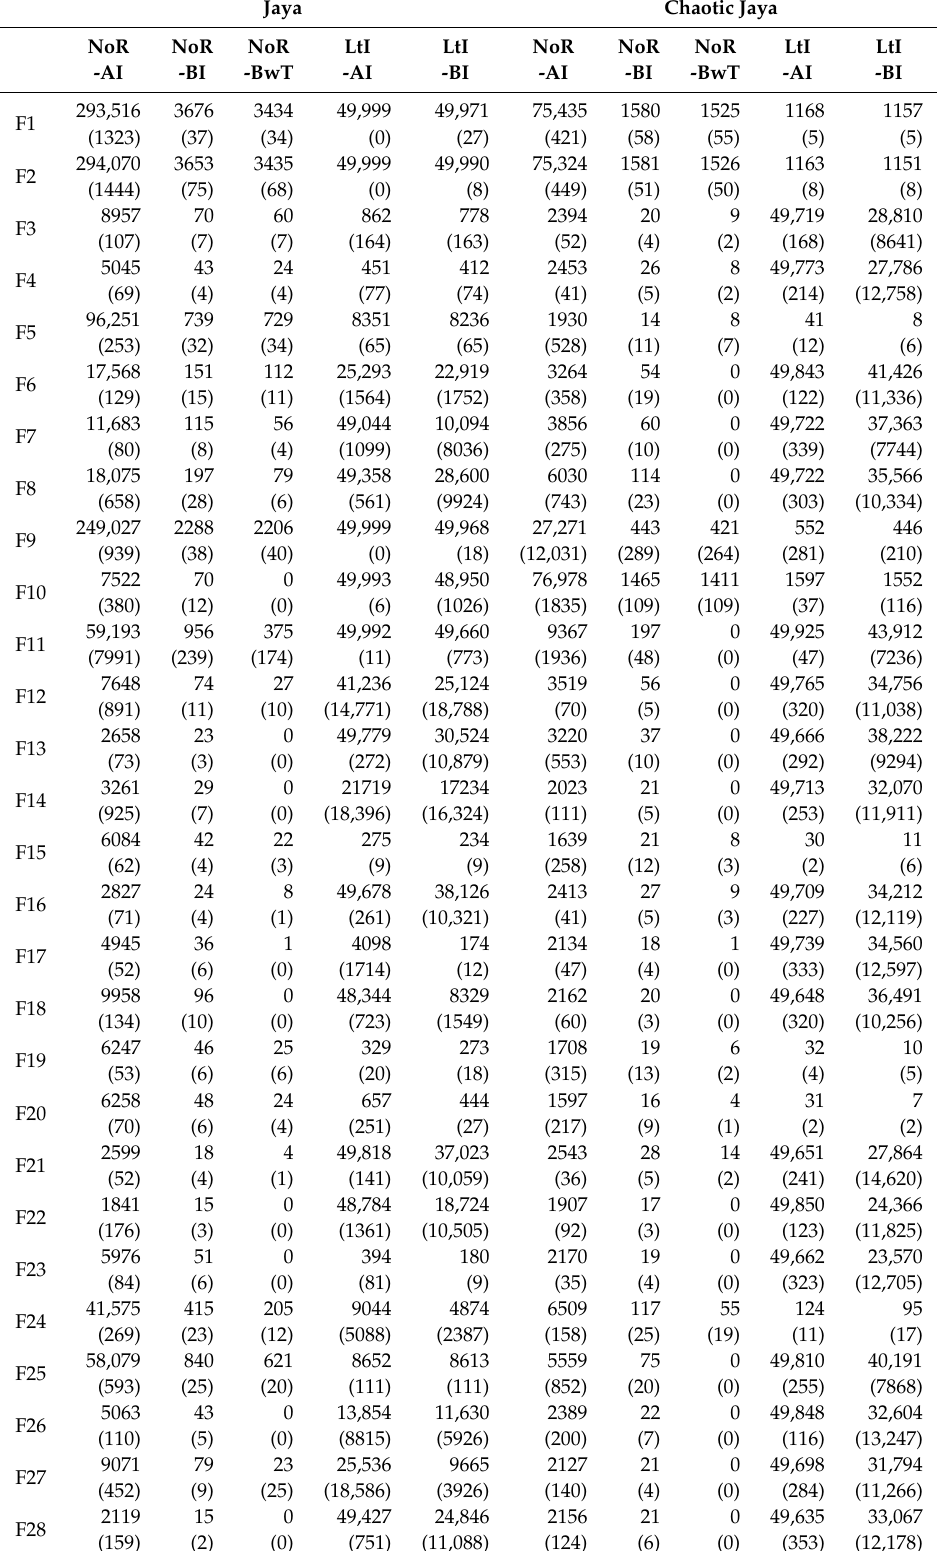
Table 3. Analysis of Jaya and chaotic Jaya on function F1-F28 with a population size of